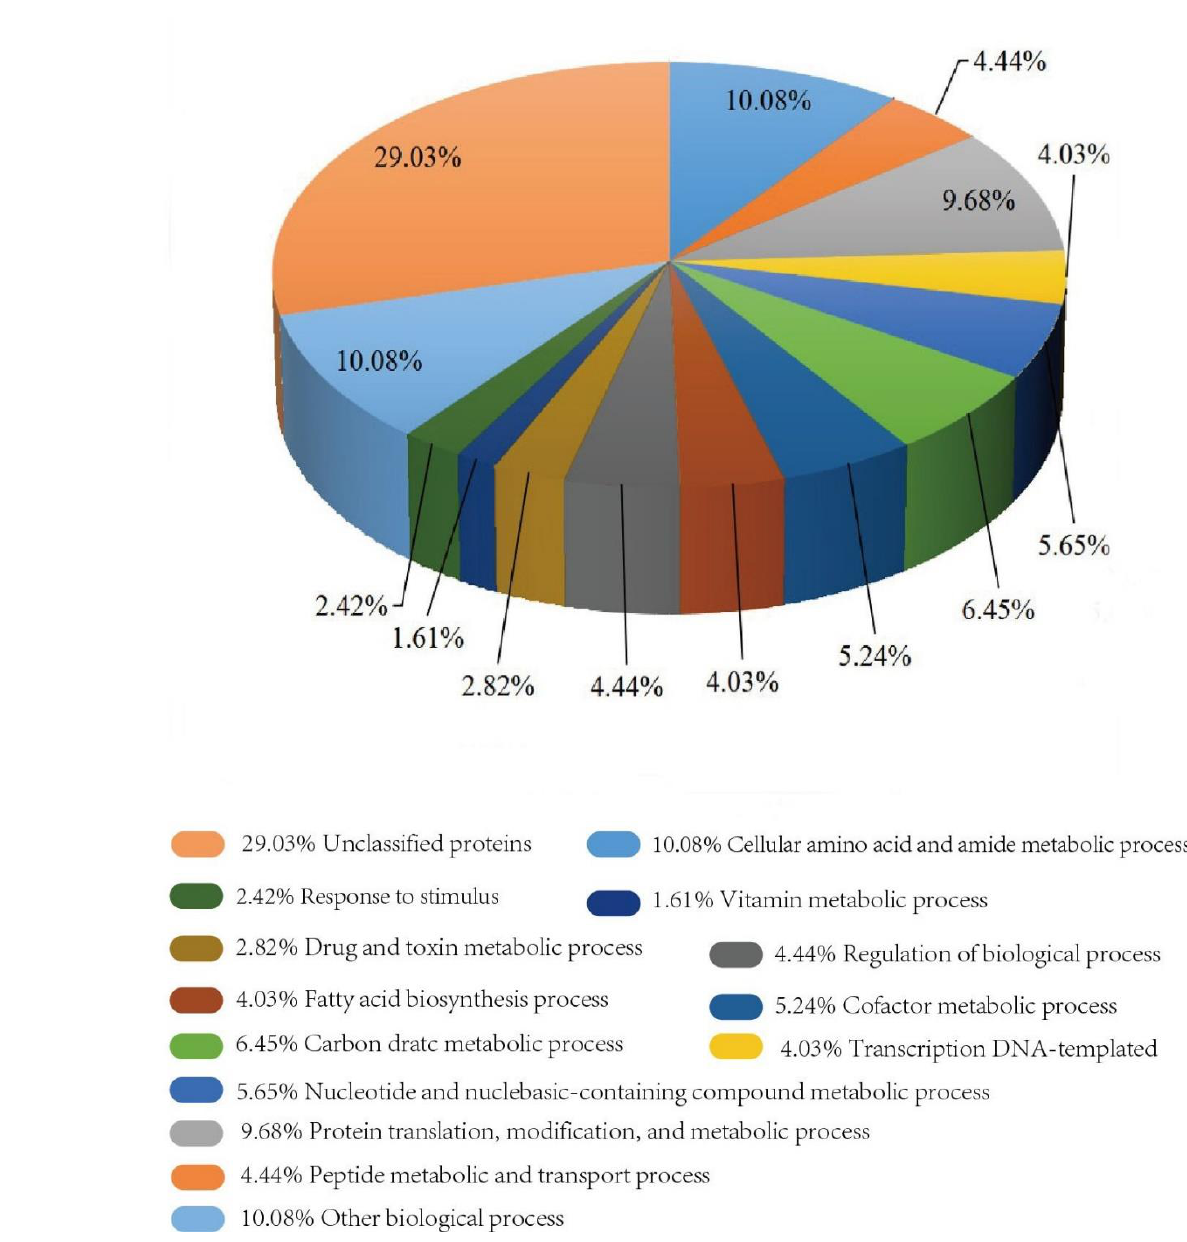
Figure 2. ( A ) Heat map of protein expression. ( B ) Gene ontology (GO) term enriched broader process classification of the 248 differentially expressed proteins during B. amyloliquefaciens fmb-60 cells cultivated in ML and MLF.